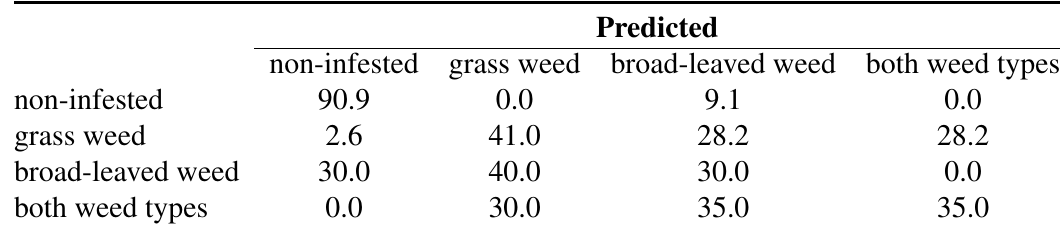
Table 4. Confusion matrix of the canonical discriminant classification showing the percentage of correct group classifications with four groups (first sampling